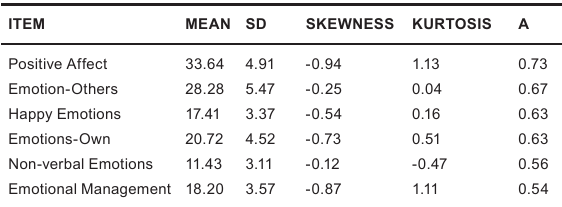
table 5 Descriptive statistics and Cronbach alpha coefficients of the SEIS